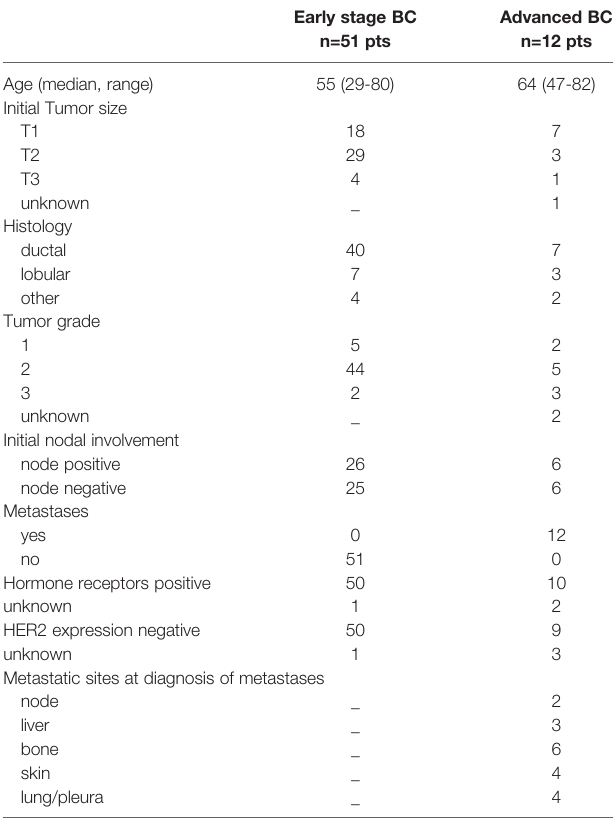
TABLE 1 | Clinico-pathological parameters for the breast cancer patients ’